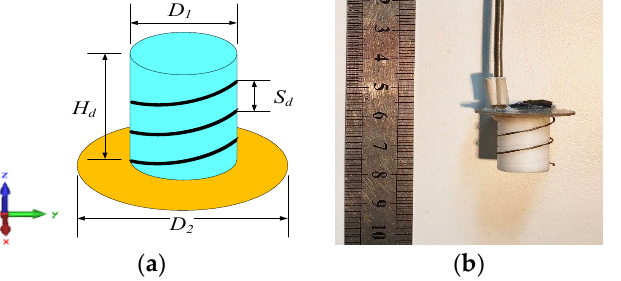
Figure 17. Structure of the tag antenna. ( a ) Geometry of the helix antenna. ( b ) Photograph of helix antenna.